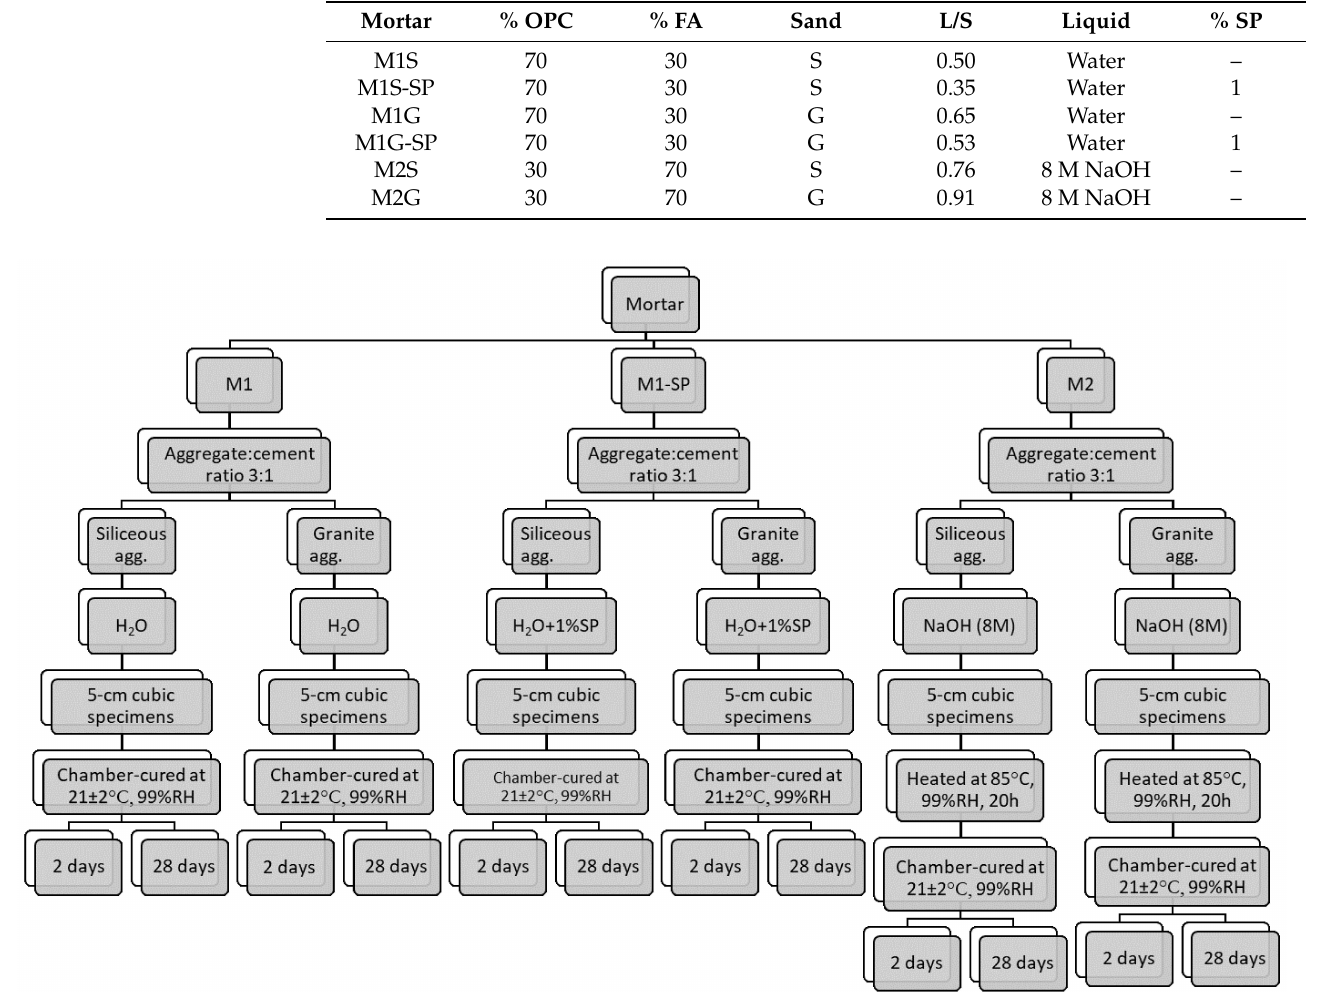
Table 6. Mortars prepared.